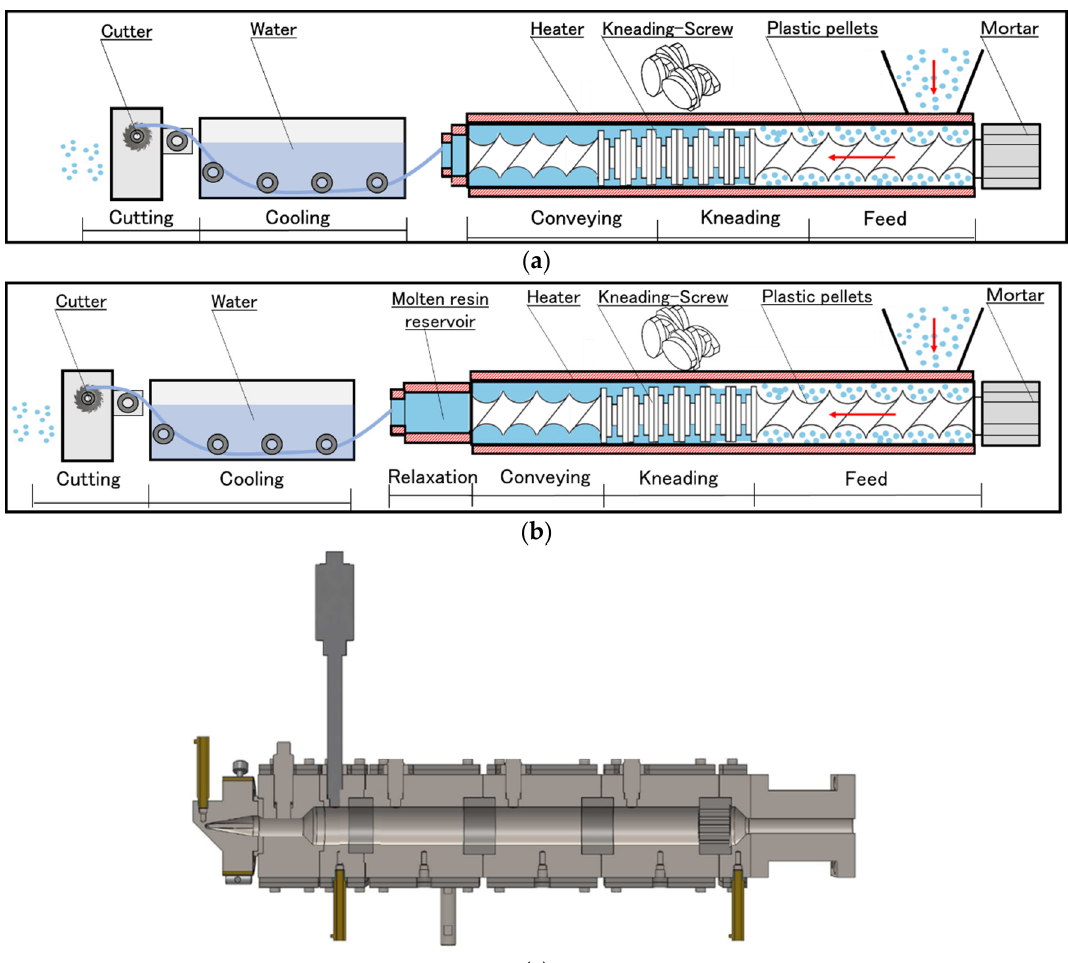
Figure 1. Schematic of the screw extruder ( a ) without and ( b ) with the molten resin reservoir, and ( c ) cross-sectional schematic of the molten resin